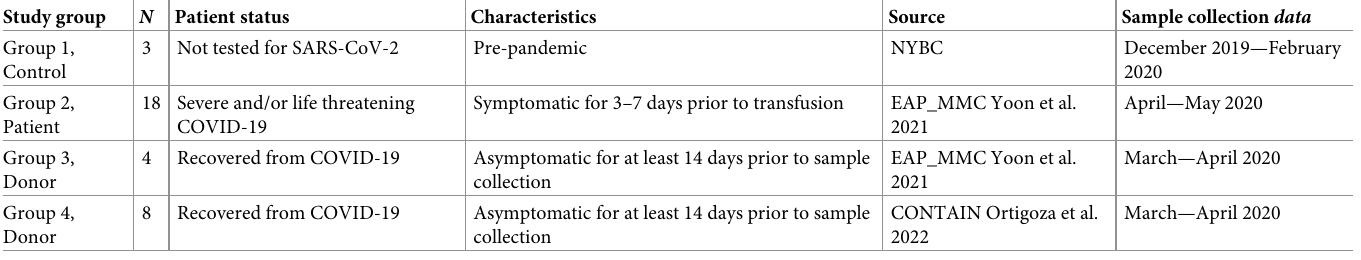
Table 1. Information on sera/plasma samples tested in this